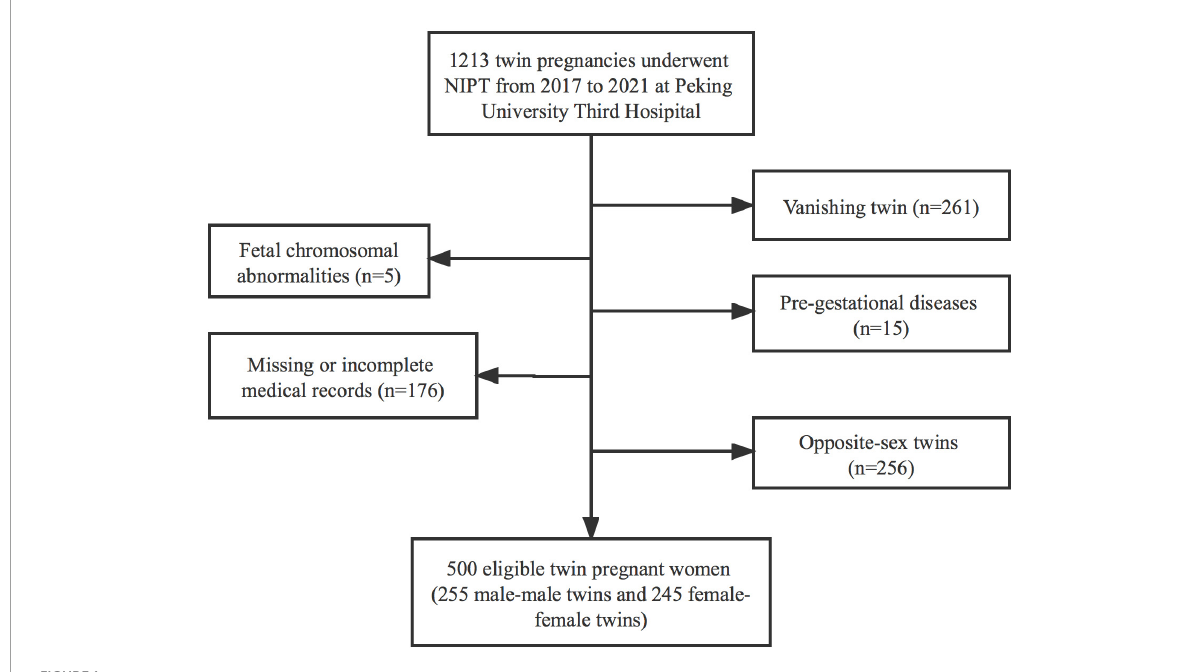
FIGURE1 Flow chart of the study